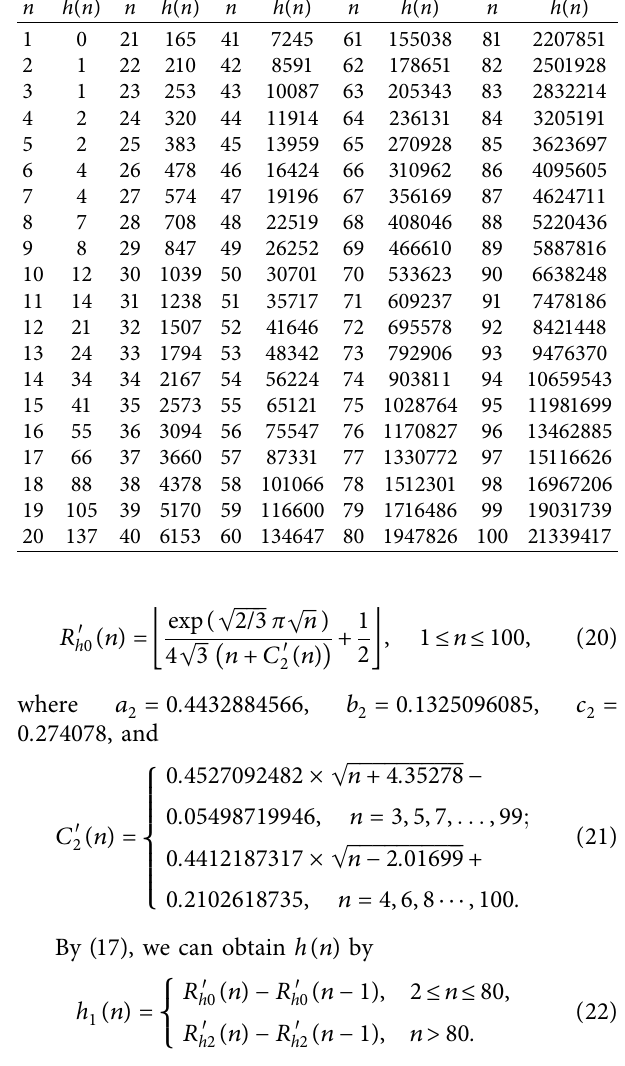
Table 1: The value of h ( n ) when 1 ≤ n ≤